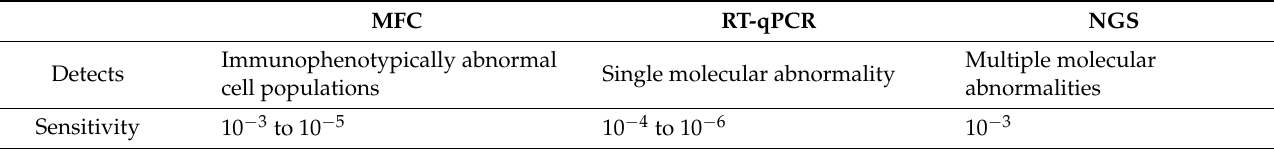
Table 1. Techniques for MRD